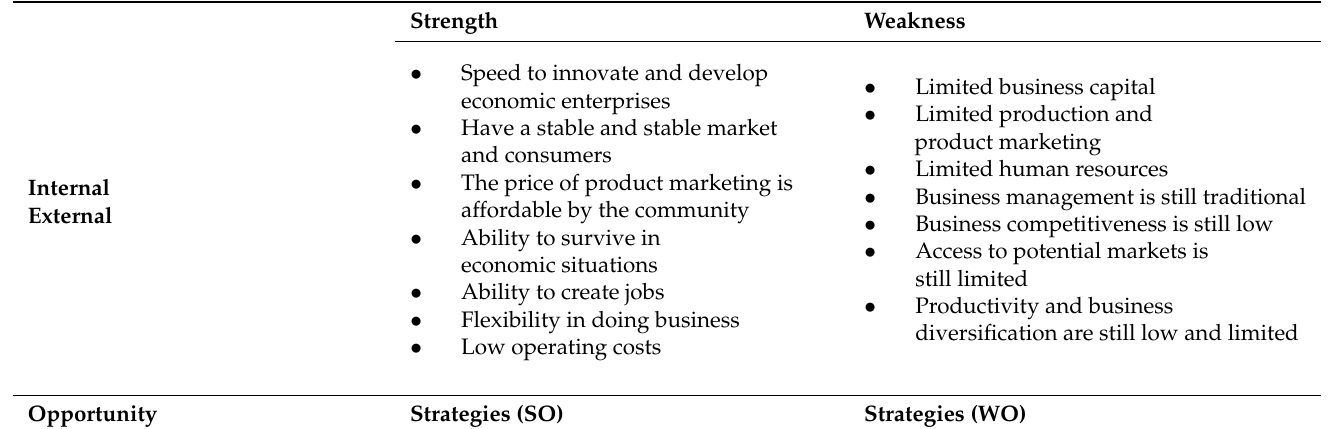
Table 7. Strategies to increase the productivity and product marketing of